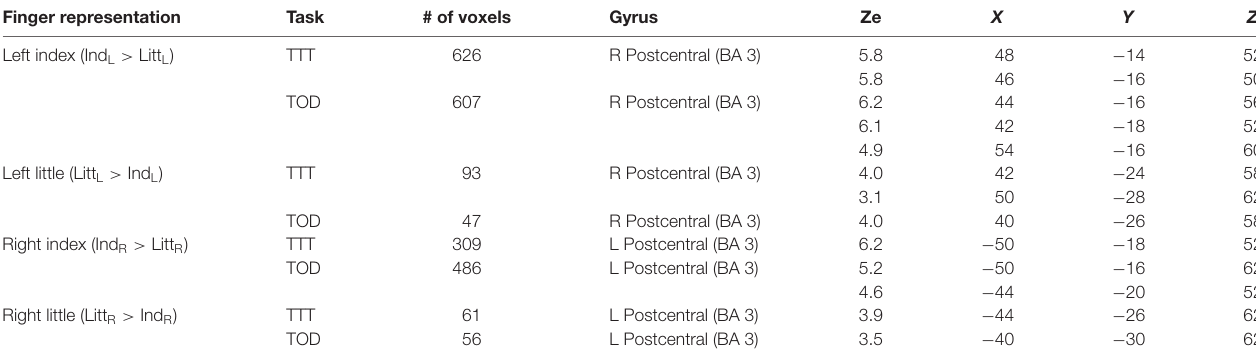
TABLE 2 | Finger representations in S1 contralateral to stimulated hand. Finger